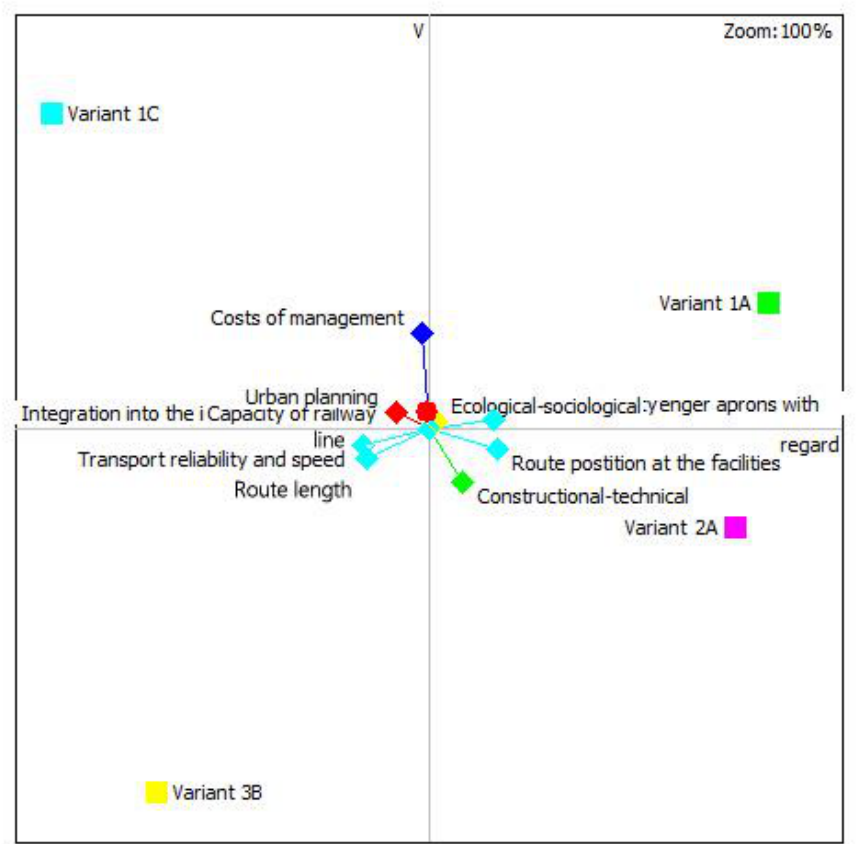
Figure 5. An overview of the result of the Scenario 1 of the multi-criteria analysis in the GAIA plane.